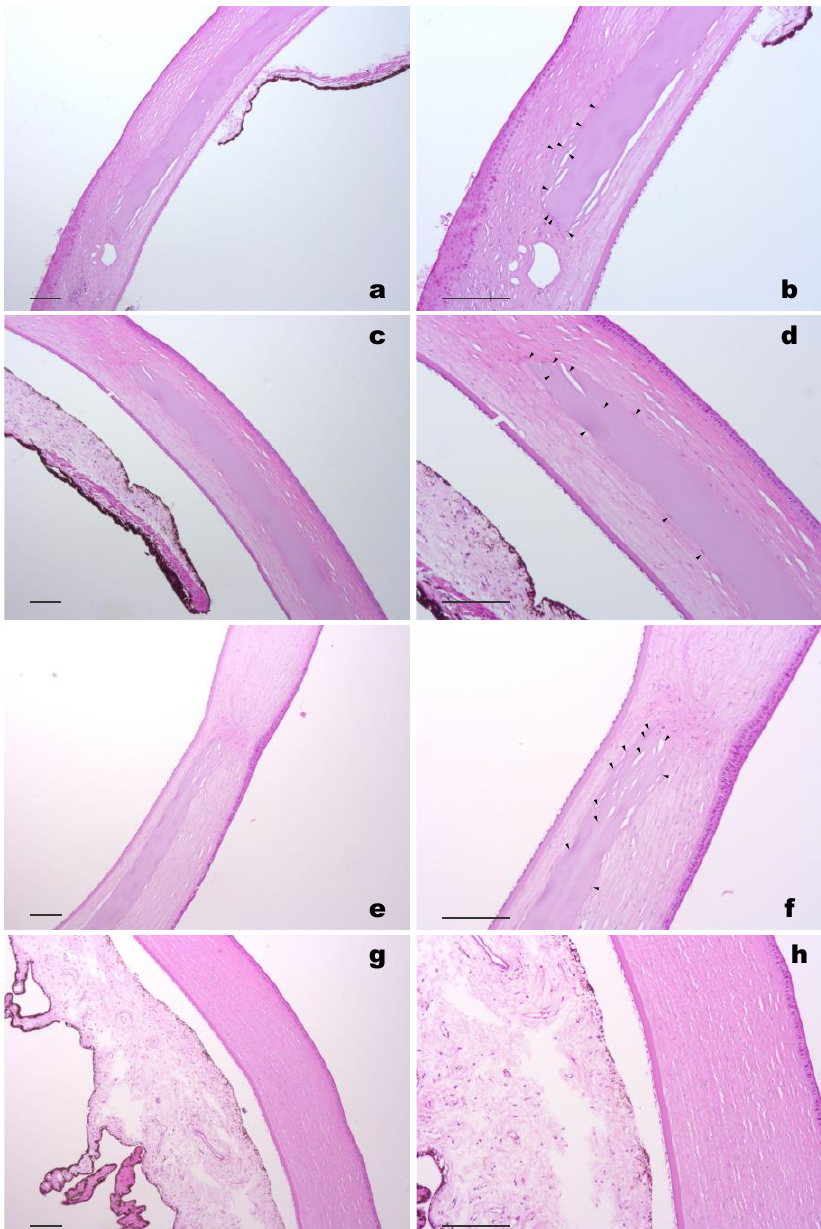
Figure 6. Hematoxylin and eosin staining of a cornea 180 days after the implantation of the collagen membrane: ( a – f ) first group, ( g , h ) intact cornea. Arrows indicate the migration of host cells into the membrane. Scale bar = 100 µ